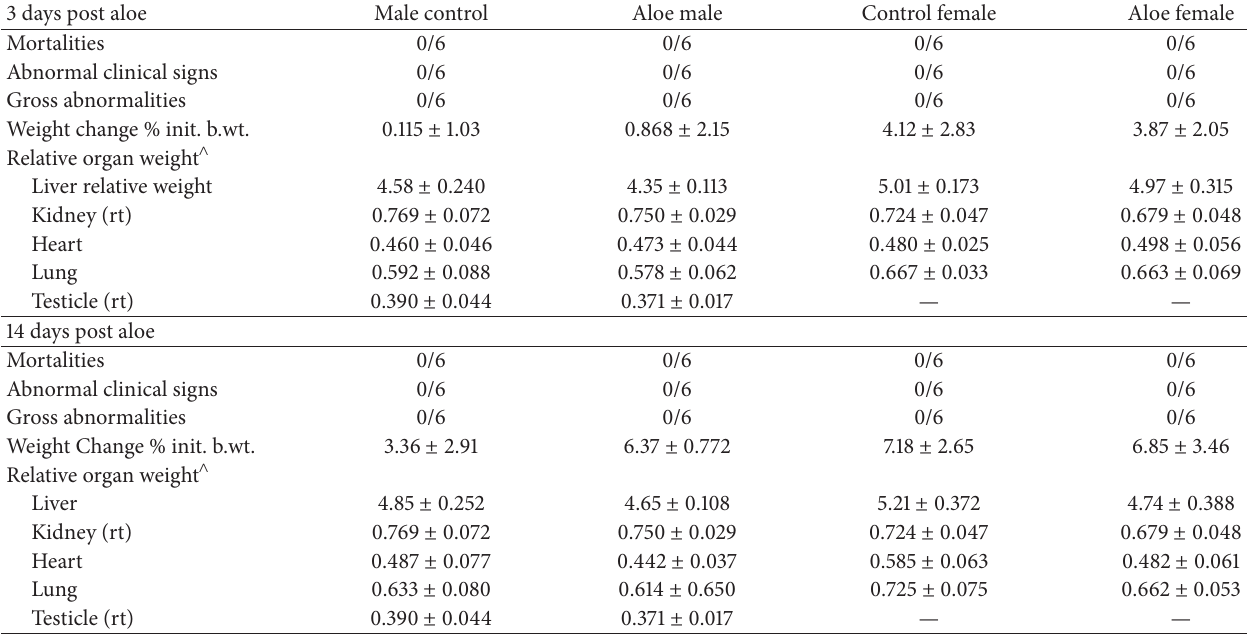
Table 2: Selected organ weights of B6C3F1 mice administered aloe juice by gavage.